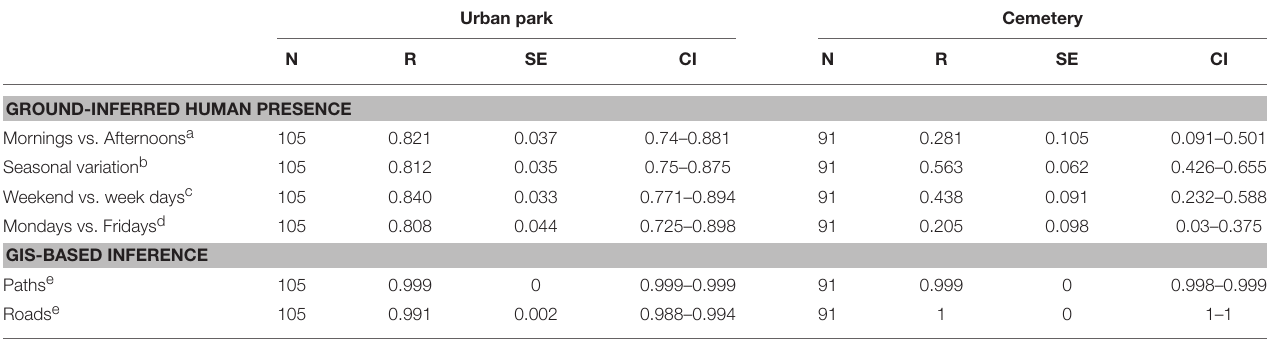
TABLE 3 | Repeatability of the human presence protocol and GIS-based approaches, with standard errors (SE) and 95% confidence intervals (CI) reported on their original scale). Urban